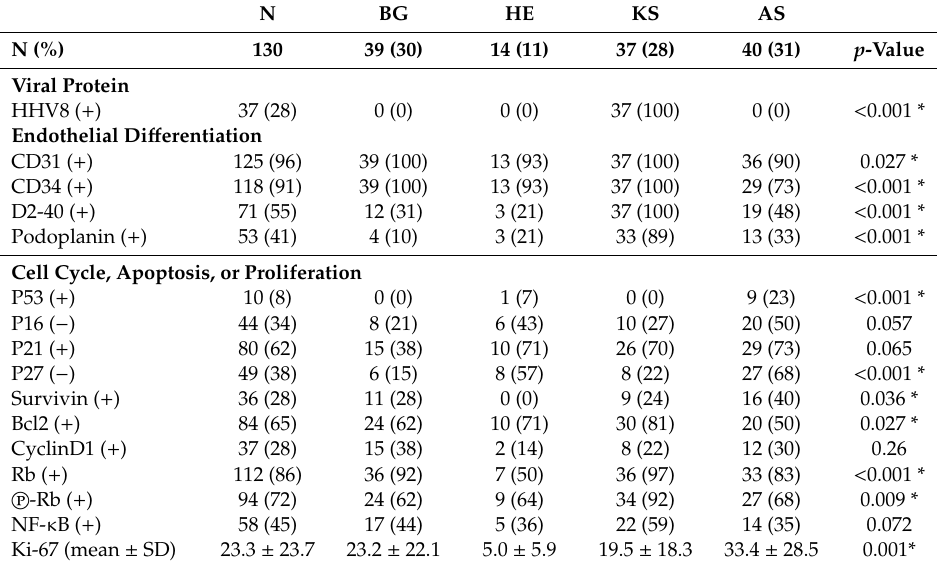
Table 1. Expression rates of 26 markers in four disease